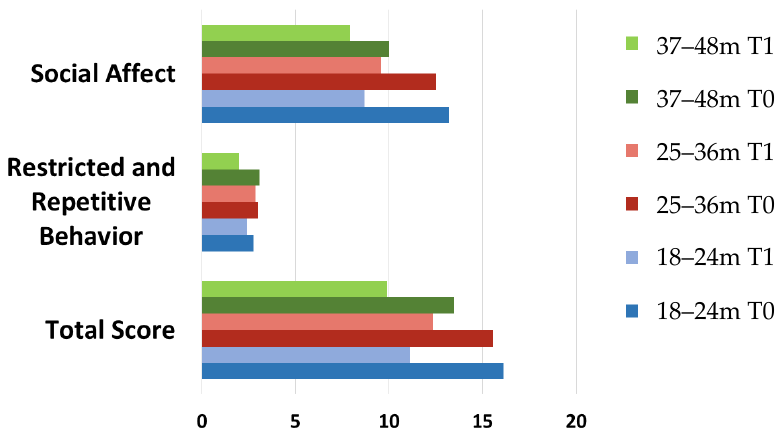
Figure 2. Age class and sub-scales (Social Affect, Restricted and Repetitive Behaviors, and Total) ADOS-2 scores at baseline and at 1-years follow-up. ADOS-2 = Autism Diagnostic Observation Scheme 0. = 1-year follow-up data collection.